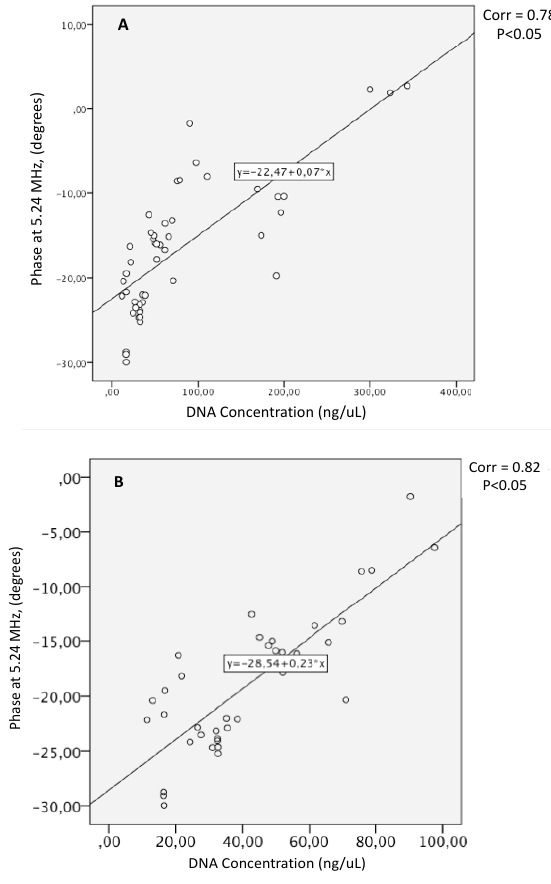
Fig.4: Dispersion diagrams of DNA concentration vs bioimpedance with a phase at 5.24 MHz. All DNA values (A) and DNA values below 100 ng/ μ L